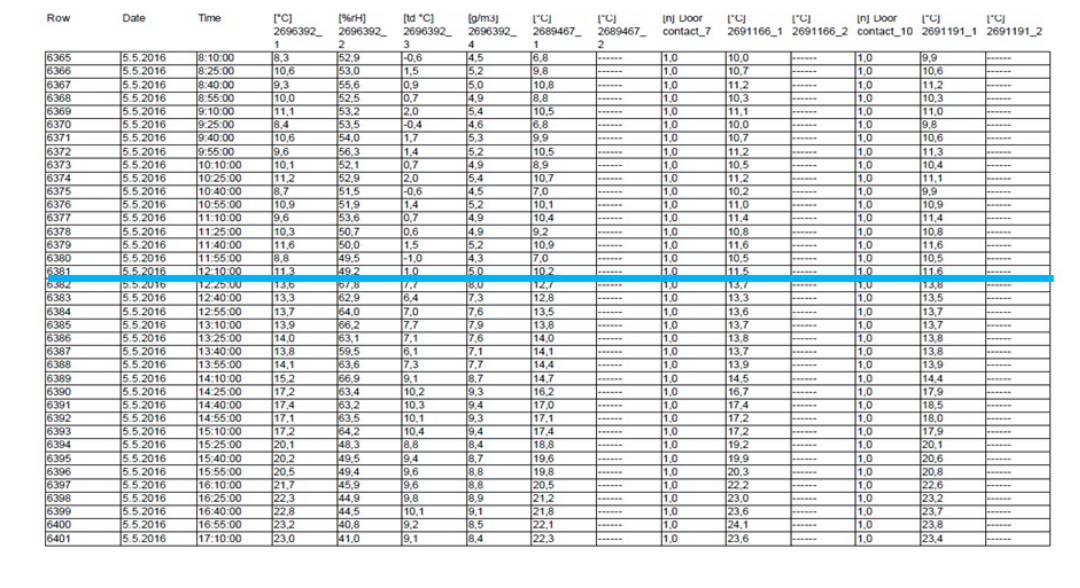
Figure 4: Transport temperatures of eggs. Transport between Vel’ký Krtíš to Beckov and Beckov to Madunice.